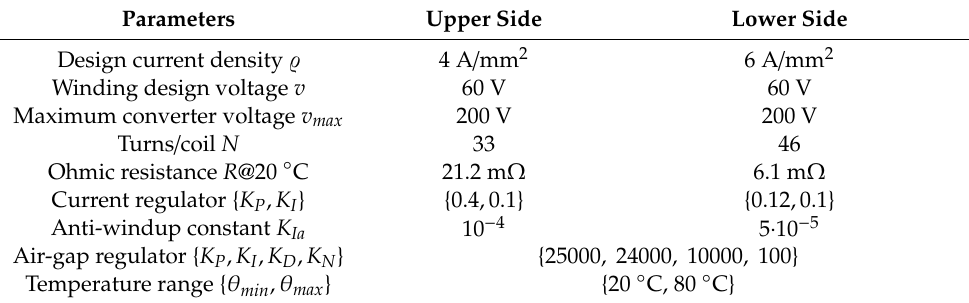
Table 5. Main parameters of the AHMB control